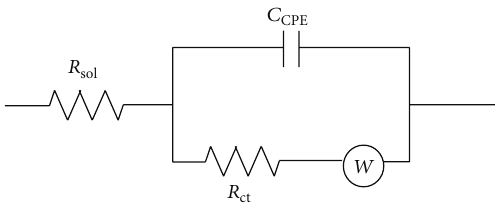
Figure 8: Equivalent electrical